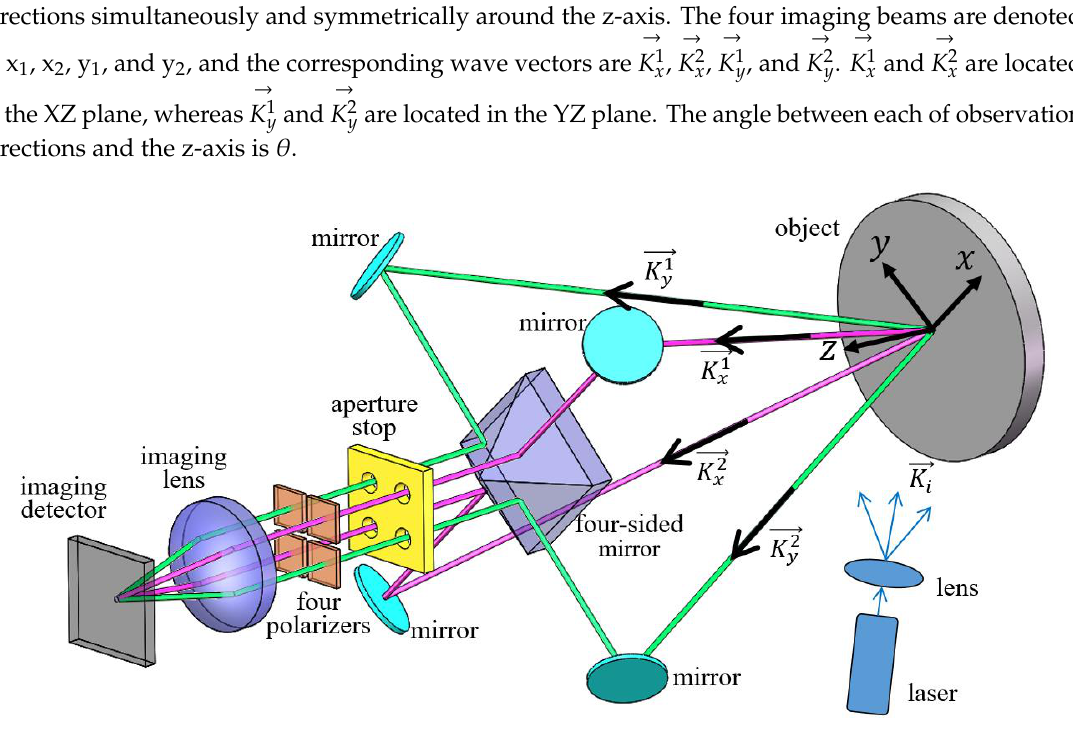
Figure 1. Schematic diagram of digital speckle pattern interferometry (DSPI) to simultaneously measure two in-plane displacements.